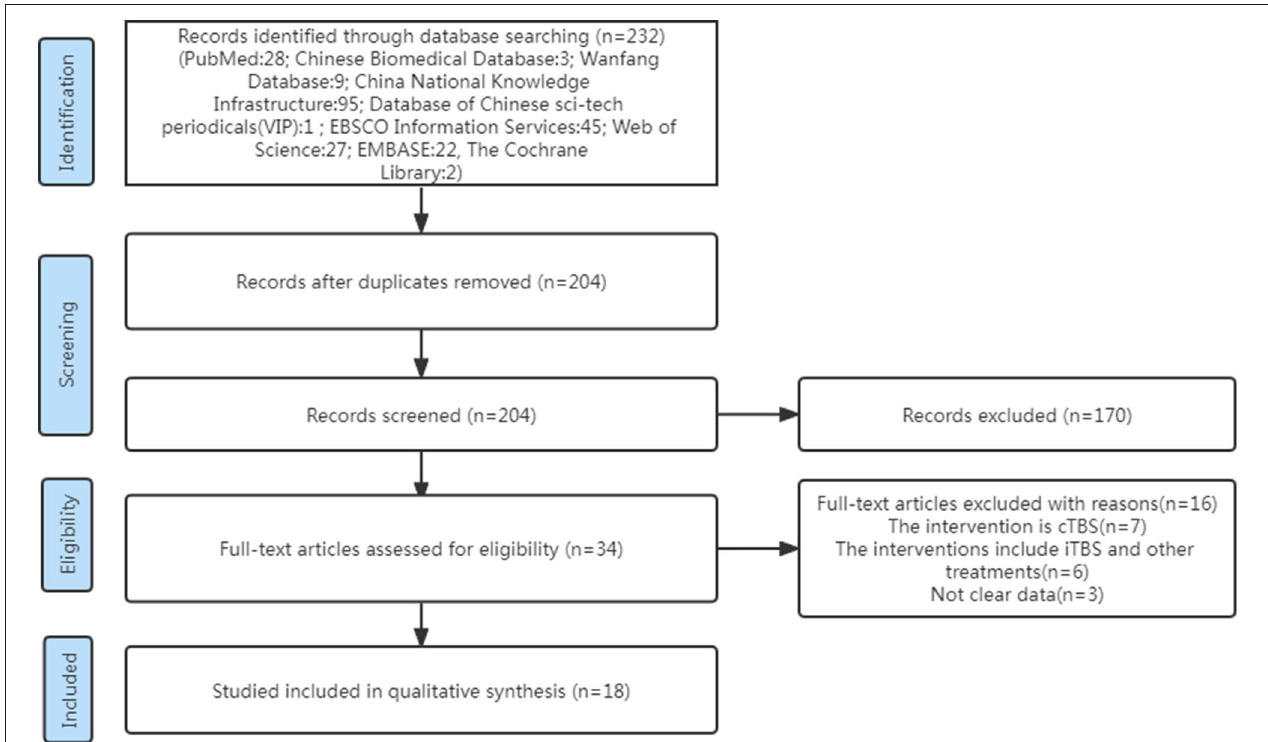
FIGURE 1 | Flowchart for identification of